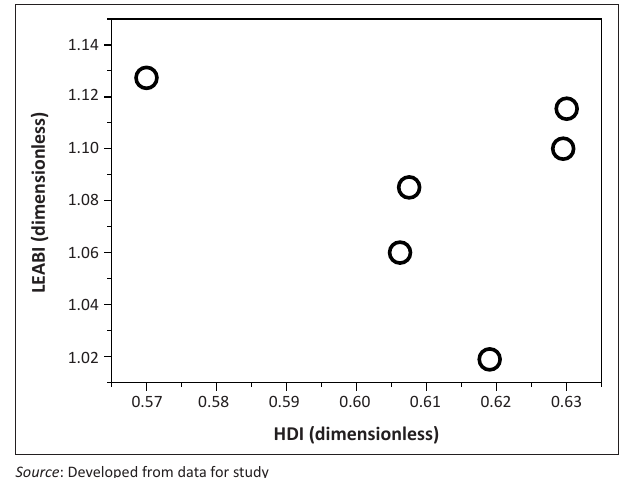
HDI (dimensionless)